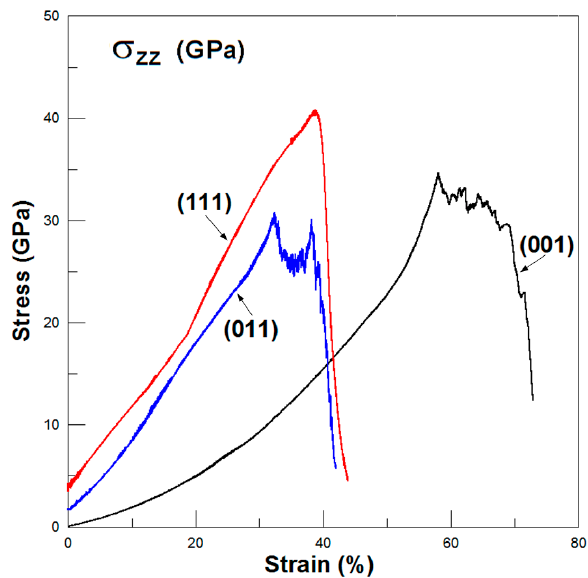
Figure 12. MLS stress-strain curves.